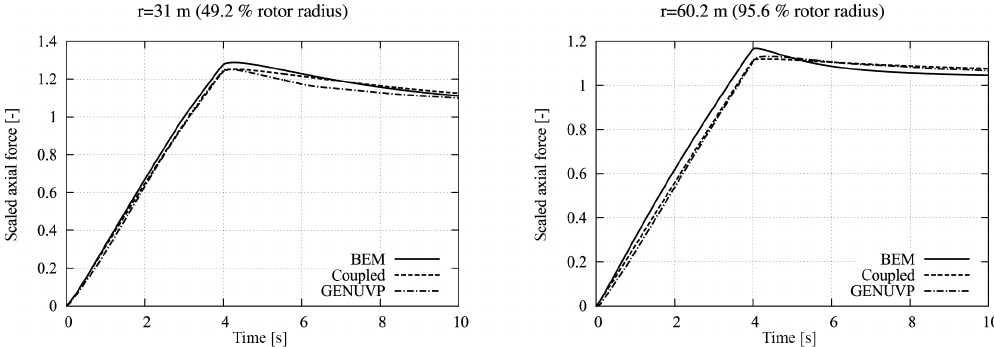
Figure 14. Scaled axial force at different radial positions during and after a pitch step by 5 ◦ in